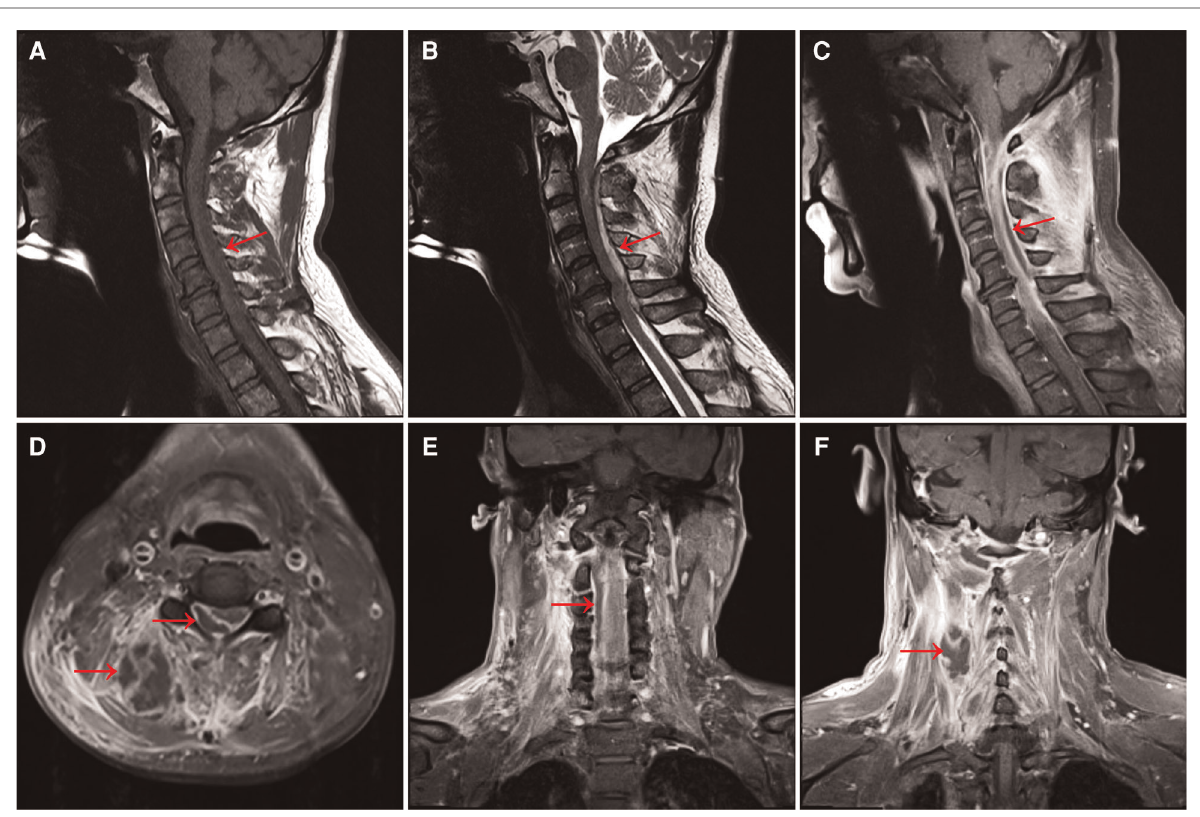
FIGURE 1 ( A ) MRI T1-weighted image shows a long strip of isointense lesions on the dorsal side of the spinal cord in the C1 – C7 spinal canal. Also see C5/6 intervertebral disc herniation, and the corresponding dura and spinal cord are compressed. ( B ) T2-weighted image shows hyperintensity of the lesion. ( C ) T1-enhanced image showed annular enhancement of the lesion, no obvious internal enhancement, and spinal cord compression at the corresponding level. ( D ) Axial T1-enhanced image showed a large range of irregular non-enhanced areas in the soft tissue of the right posterior side of the cervical spine, and a ring-enhancing lesion in the right posterior part of the spinal cord in the spinal canal, with no obvious internal enhancement. ( E ) Coronal T1-enhanced image shows a slightly hypointense lesion on the right side of the spinal cord in the cervical spinal canal and ( F ) a honeycomb-like non-enhancing area in the soft tissue on the right side of the spinal canal.